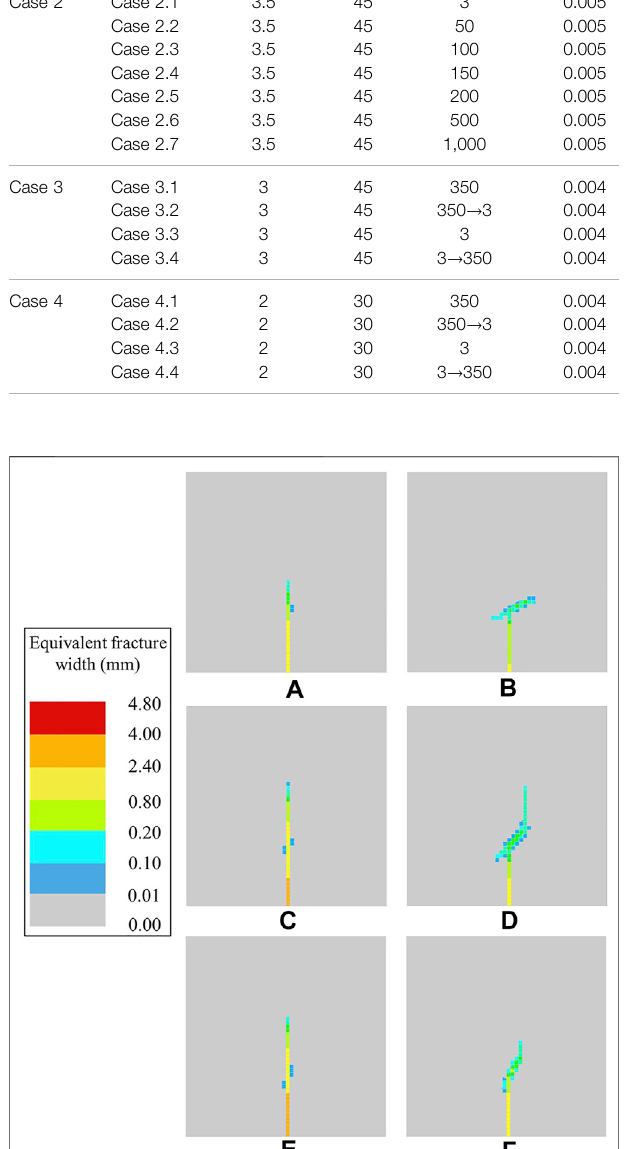
FIGURE 7 | Fracture equivalent width contours: (A) Case 1.1, (B) Case 1.2, (C) Case 1.3, (D) Case 1.4, (E) Case 1.5, and (F) Case 1.6.